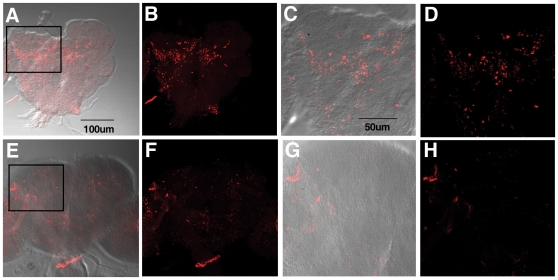
Effect of NQTrp on Aβ in drosophila brains.Immuno-staining of two-day old adult fly brains with specific Aβ antibody 6E10. (A–D) Aβarc1-42-expressing animals fed with regular fly food (elav-GAL4/+; UAS-Aβarc1-42/+). (C, D) Enlarged images of the boxed region. (E–H) Aβarc1-42-expressing animals fed with NQTrp (elav-GAL4/+; UAS-Aβarc1-42/+) (G, H) Enlarged images of the boxed region. N = 6 for each class examined.